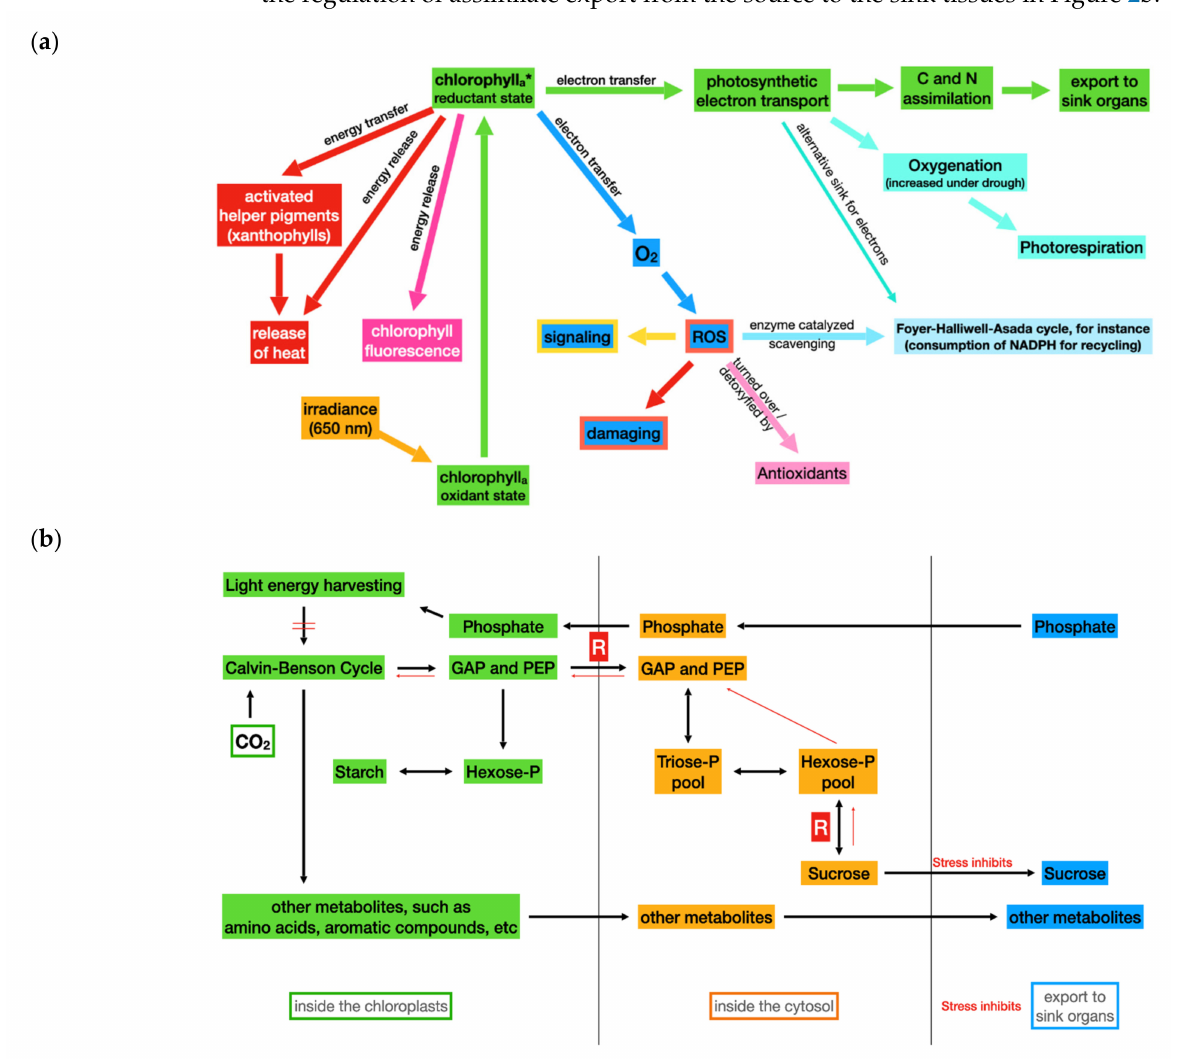
Figure 2. Light energy capture in photosynthesis. ( a ) Pathways competing for absorbed light energy. ( b ) Assimilated export of the chloroplasts via the cytosol to sink tissues. * indicates the light activated state of chlorophyll